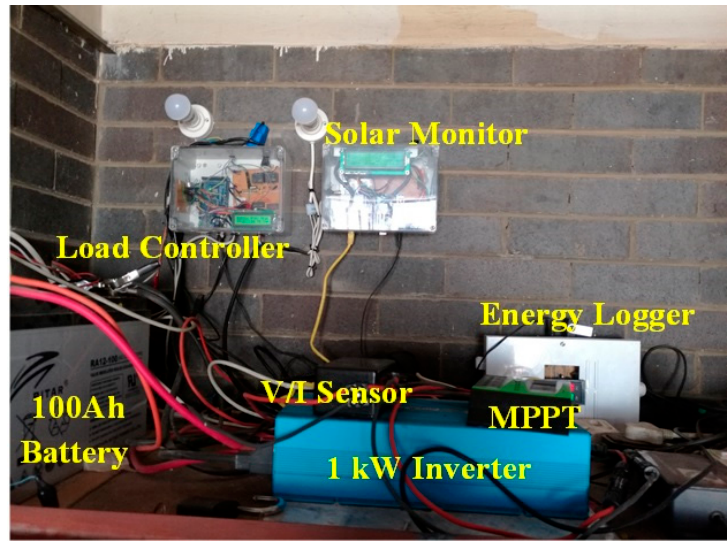
Figure 10. A hybrid renewable energy system.